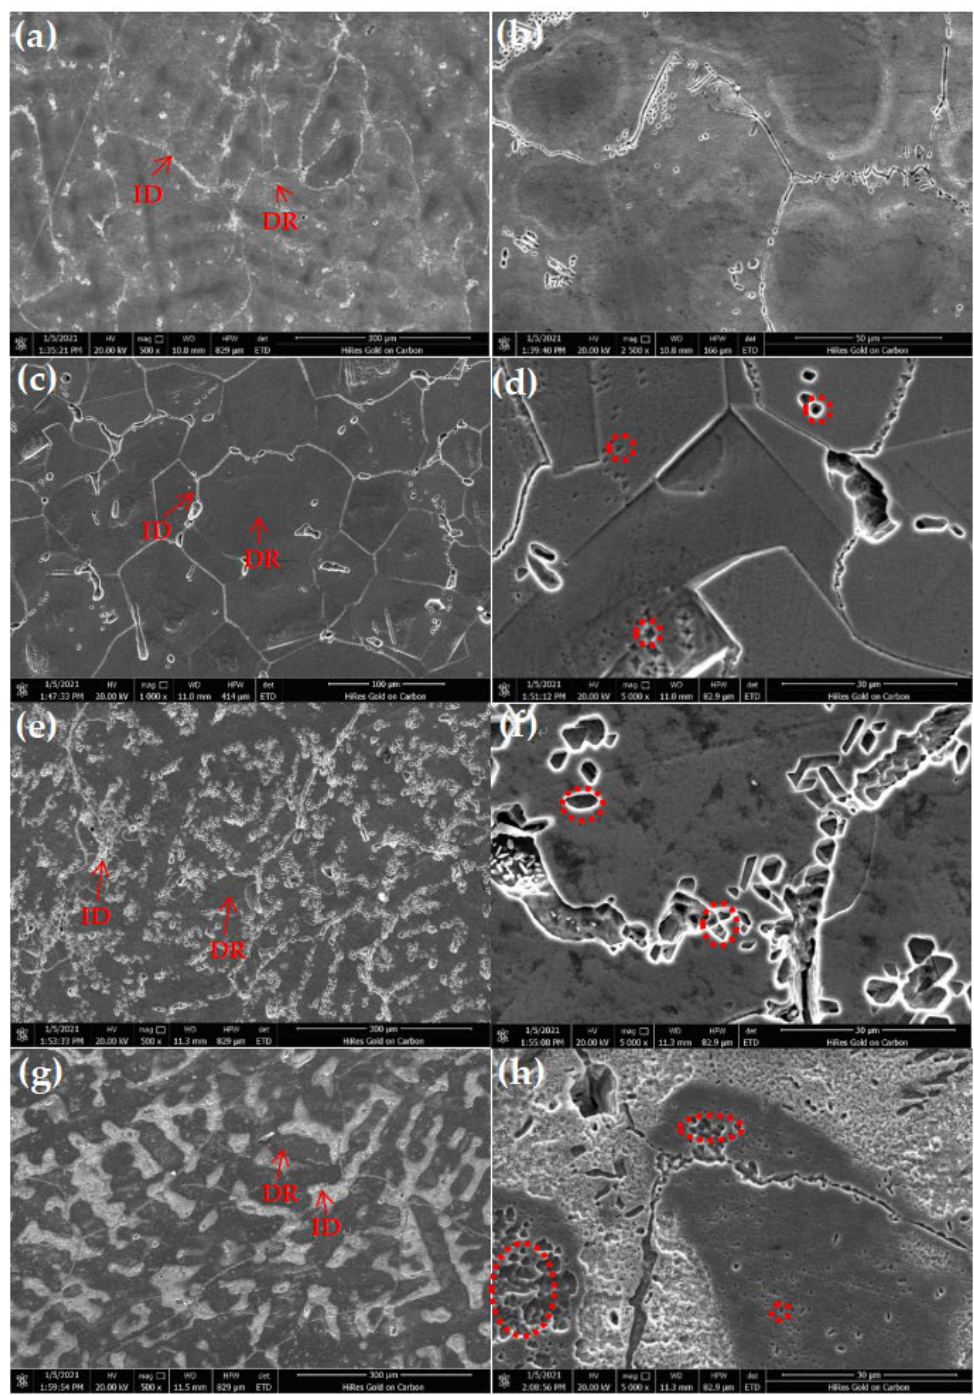
Figure 3. Microstructure morphology of (FeNi)67Cr15Mn10Al5Ti3 HEA at different annealing temperatures: ( a , b ) 700 °C; ( c , d ) 800 °C; ( e , f ) 90 0°C; ( g , h ) 1000